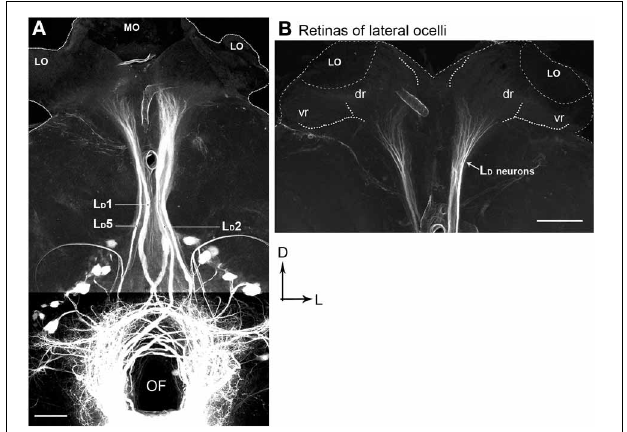
FIGURE 8 | Posterior views of stained descending neurons in the honeybee brain. (A) All descending neurons filled when dye was placed in the dorsal region of the ventral nerve cord (including the medial dorsal track: MDT). (B) Many neurons are filled but only those that travel up into the ocelli are descending ocellar neurons (L D